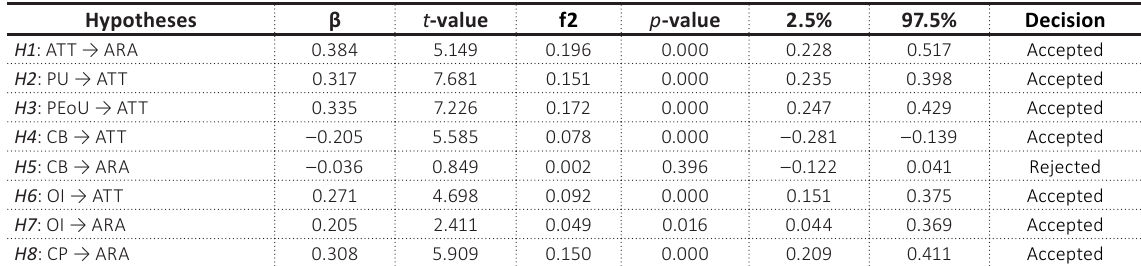
Table 4. Hypotheses testing